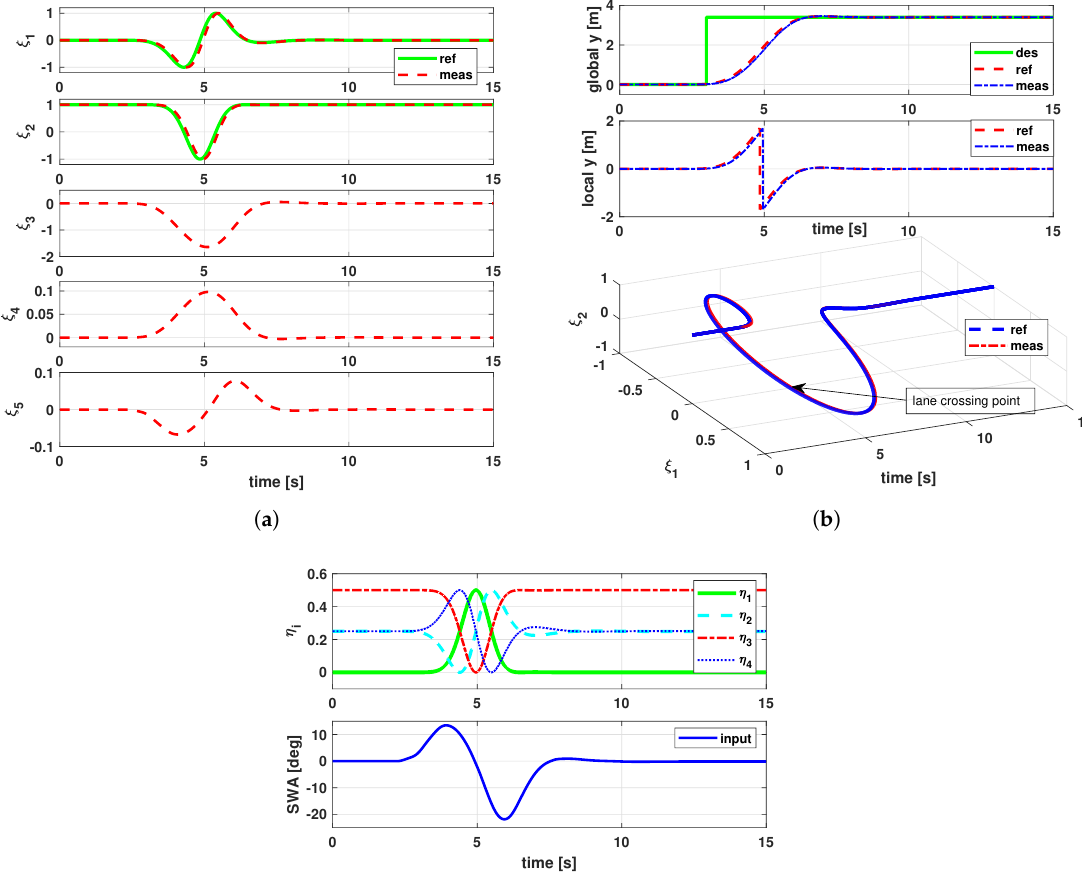
Figure 6. Result of ALCS using human driver characteristics-based trajectory. ( a ) Reference and measured states in the cylinder domain; ( b ) Trajectory of vehicle in global, local and cylinder domain, respectively; ( c ) Convex interpolation parameter and the control